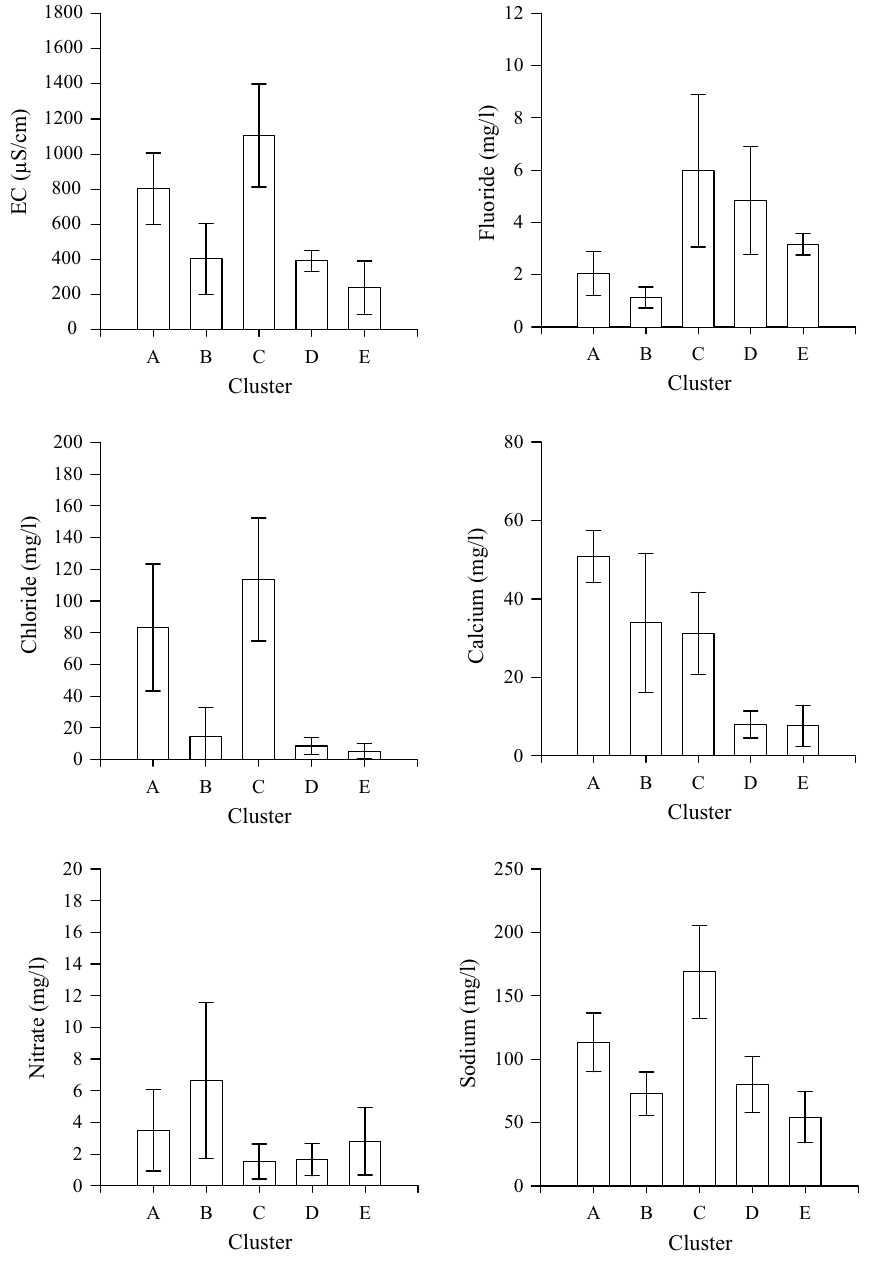
Fig. 10 Comparison of means of selected major ions for differ- ent water clusters